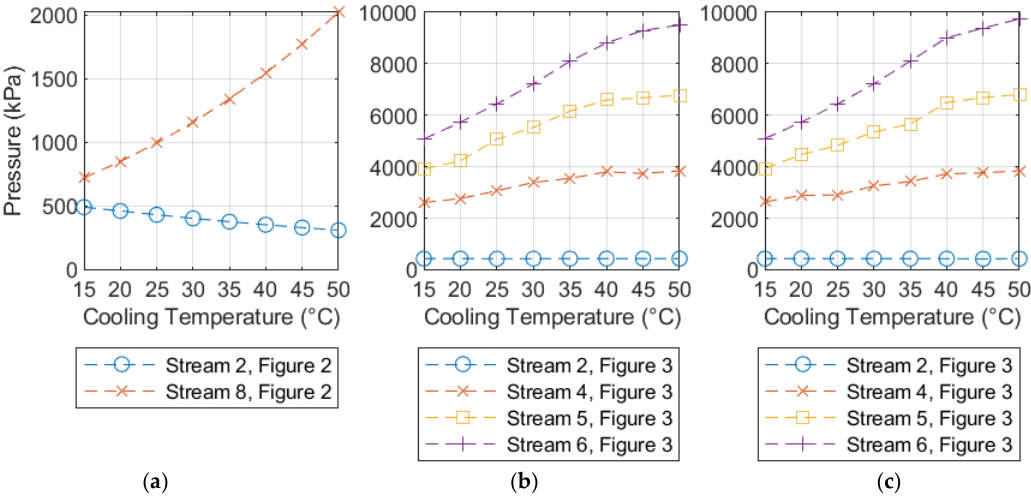
Figure 4. Variation in energy consumption for Cases 5a, 6a, and 6b with cooling temperature.